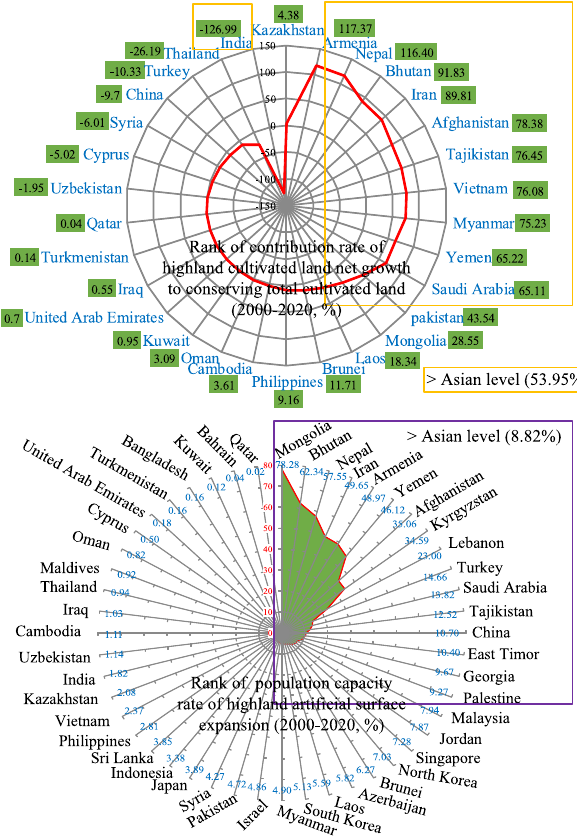
Fig. 4 | Highland developments supporting the developments in Asia from 2000 to 2020. a Contribution rates of cultivated land net growth in highlands for conserving total cultivated lands, b rank of contribution rates of cultivated land net growth in highlands for conserving total cultivated land, with 30 countries exhibiting net increase of highland cultivated land (negative value ( − ) denotes the contribution rate of cultivated land net growth in highlands for